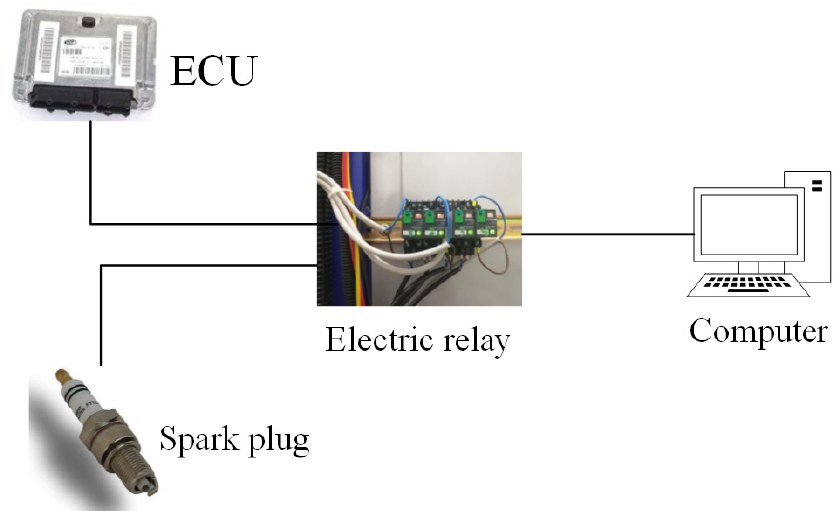
Figure 2. The schematic diagram of the control circuit.